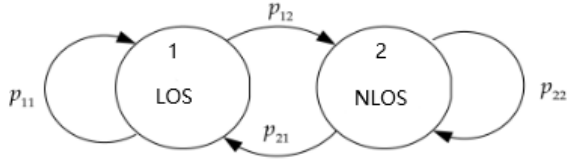
Figure 2. Markov transformation process .